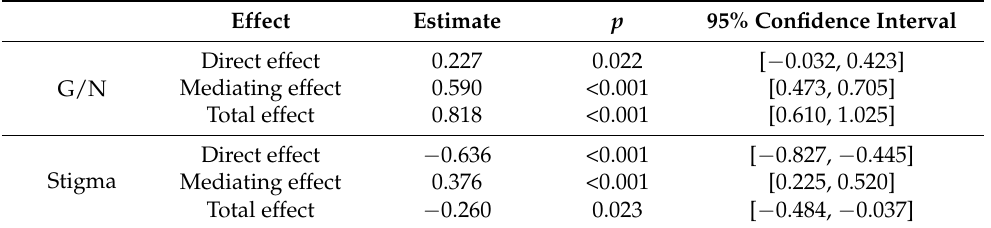
Table 4. Estimated mediating effect of suicidal ideation in the association between glorification/normalization of suicide and suicide attempts. Gender, age, and education level were added as covariates.